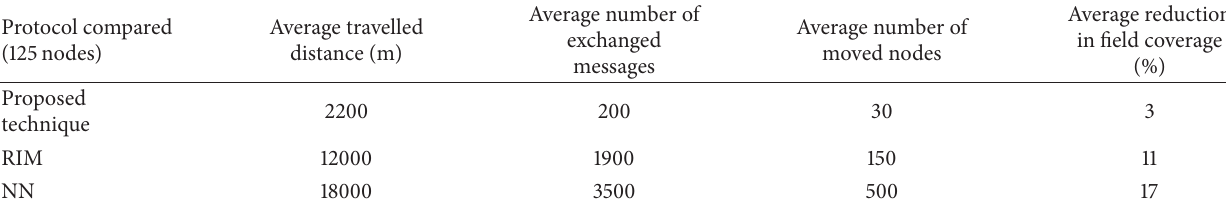
Table 3: Results